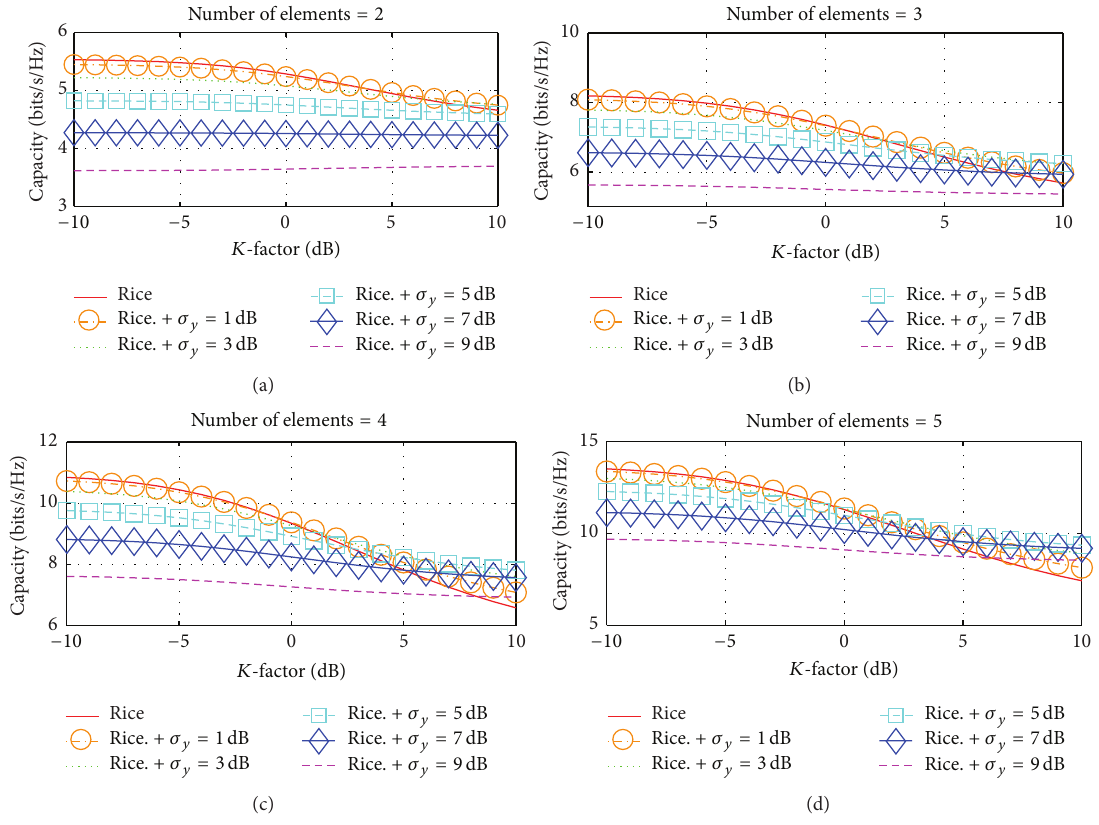
Figure 11: Capacity versus 𝐾 -factor with shadowing as parameter, (a) for 2 × 2 , (b) 3 × 3 , (c) 4 × 4 , and (d) 5 × 5